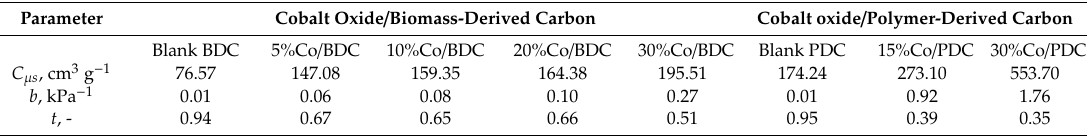
Table 2. Constant parameters of the Toth equilibrium model determined from ripening hormone adsorption data on various cobalt oxide-impregnated nanoporous carbons.